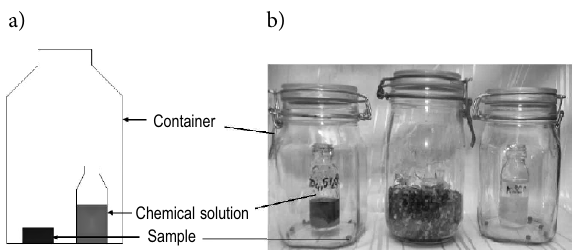
Fig. 3. CEV samples at controlled moisture: (a) schematic of the implementation tool (b) picture of the implementation tool